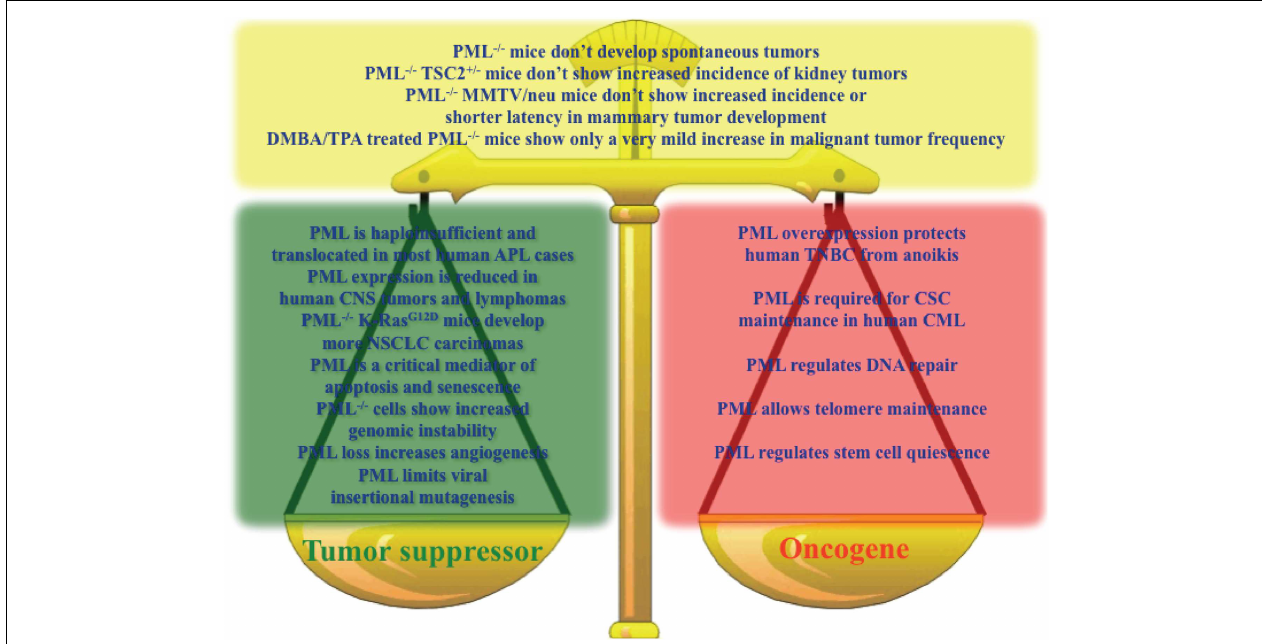
FIGURE 1 | Key results sustaining a role for PML as a tumor suppressor (green box), oncogene (red box), or in contrast with the hypothesis that PML is a tumor suppressor (yellow box) .